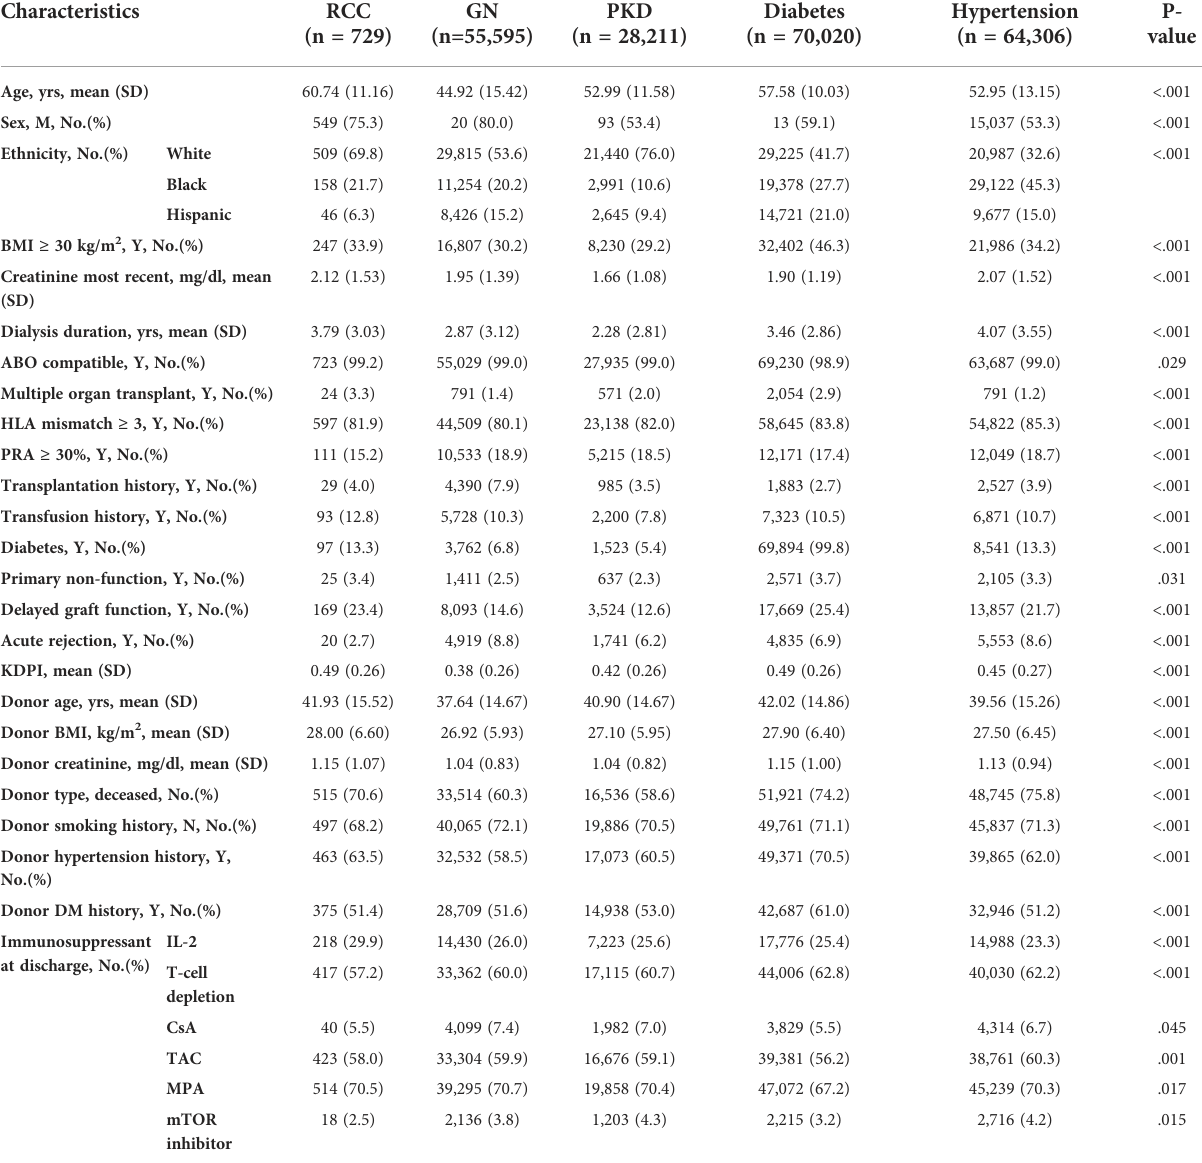
TABLE 3 Demographic and clinical characteristics of the recipients and